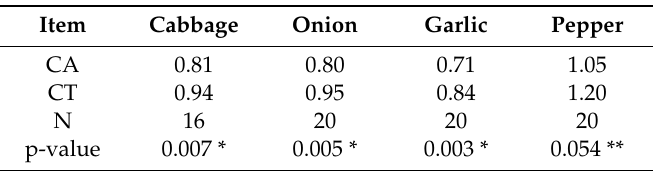
Table A5. A one tailed paired t-test of average crop coe ffi cient values of cabbage, onion, garlic, and pepper throughout the crop base period. Item Onion